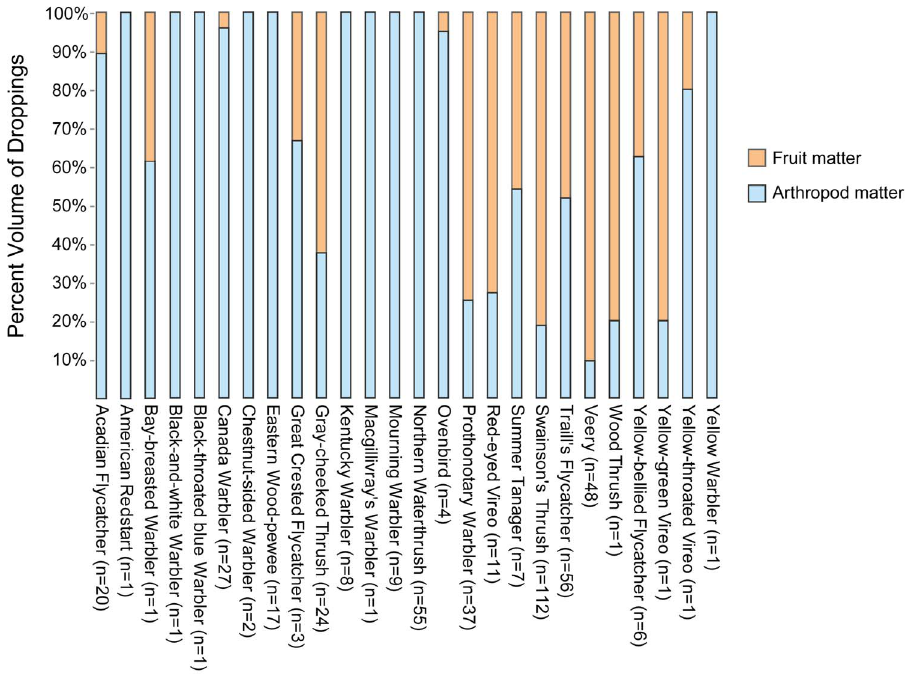
Figure 2. Averaged volumetric estimates of dropping contents and associated sample sizes for migrant birds captured in Tortuguero, Costa Rica, during 1 sept. – 31 Nov. 2008.